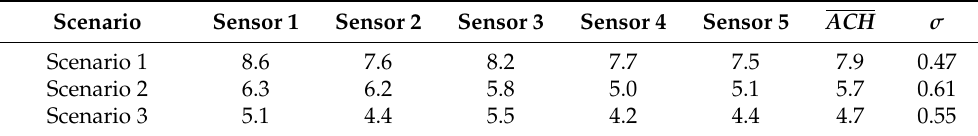
Figure 4. VR according to the ventilation scenario. Open windows are indicated by green shading in the figure. Table 2. ACH results obtained in each cross-natural ventilation scenario.